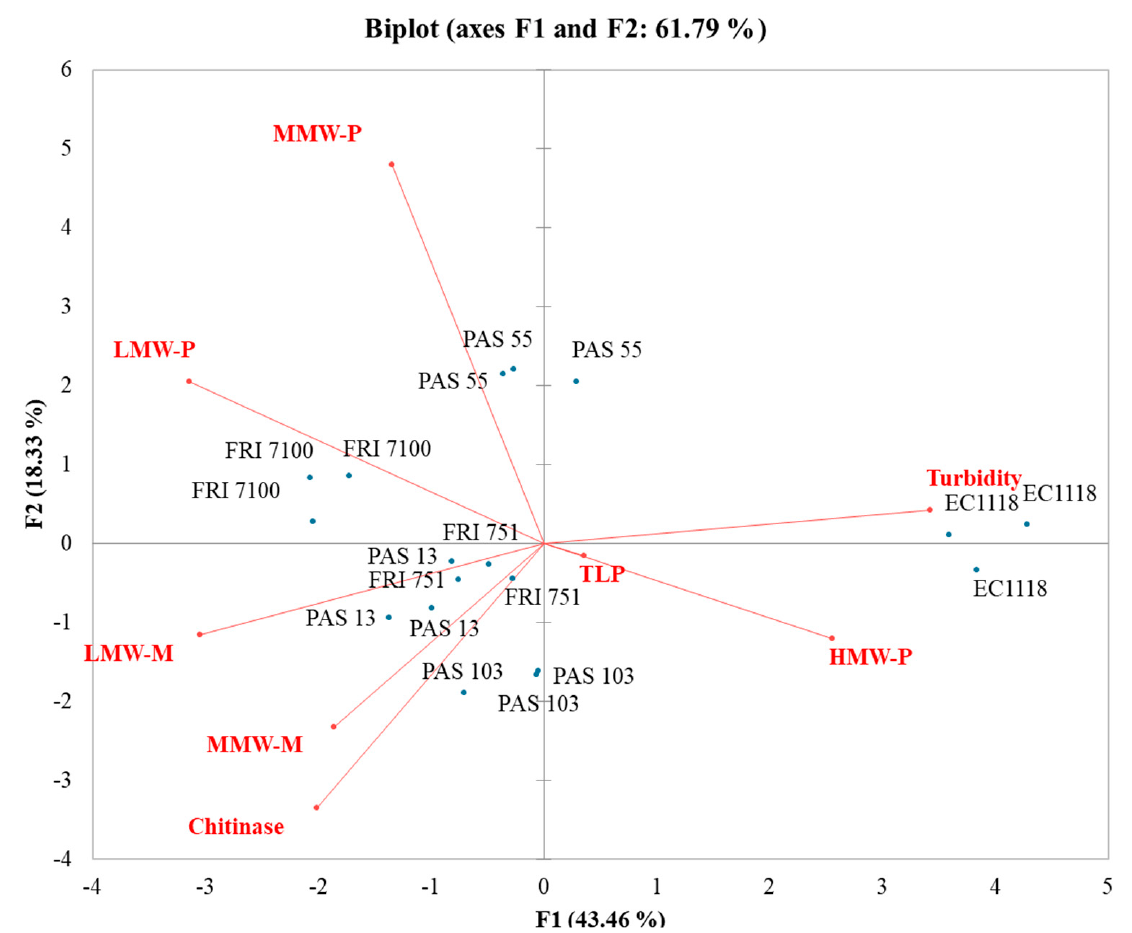
Figure 5. Principal component analysis (PCA) biplot of turbidity, grape proteins, polysaccharides, and mannoproteins in Manzoni bianco wines.